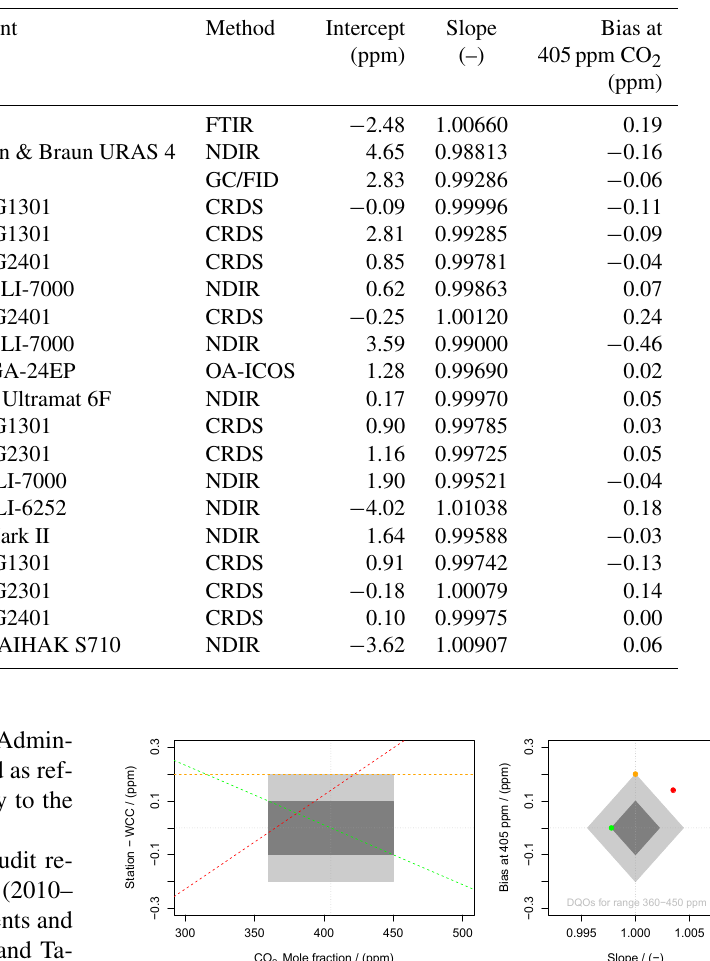
ing slope that still meets the extended DQO of 0.2 ppm (or- ange dashed line/dot) and a case with a slope/bias combina- tion that does not meet the DQOs (red dashed line/dot) over the entire relevant mole fraction range.